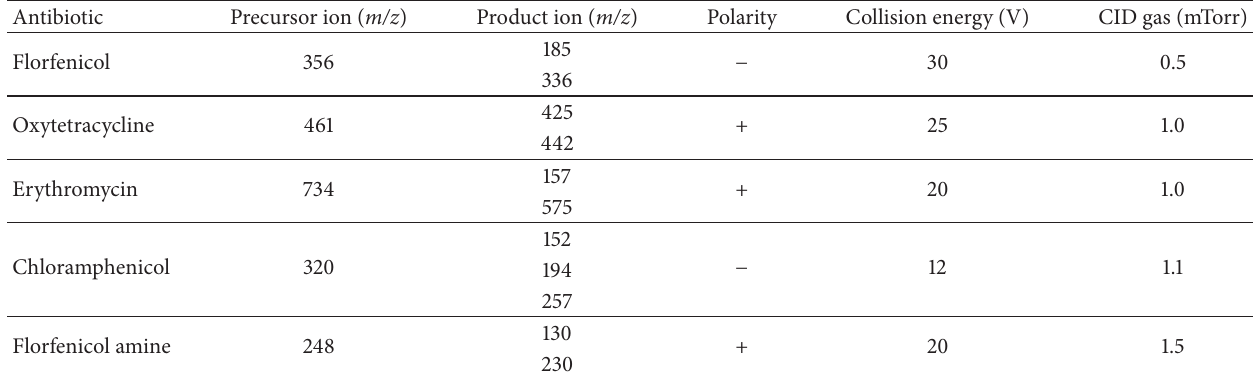
Table 1: Values employed in the antibiotic analyses by SRM.